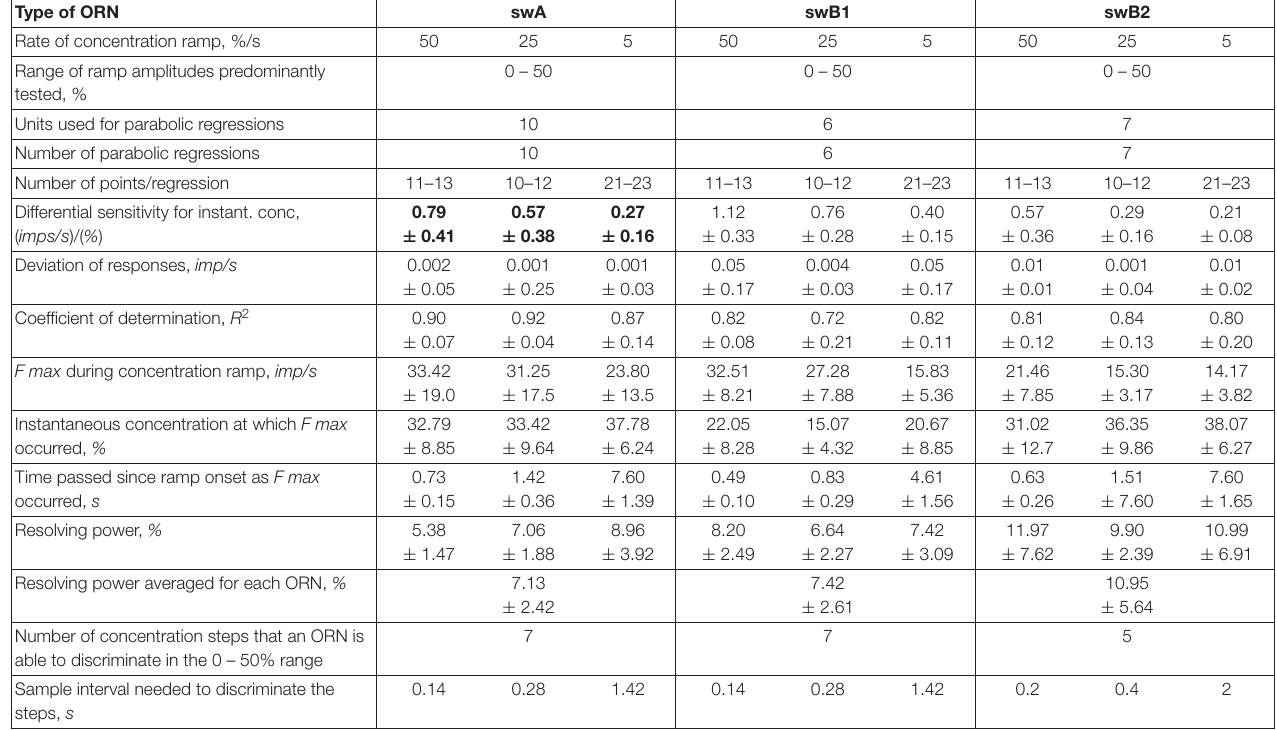
TABLE 2 | Summary of data used to determine differential sensitivity and resolving power of the swA and the two swB ORNs at ramp-like concentration increase. Type of ORN swA swB1